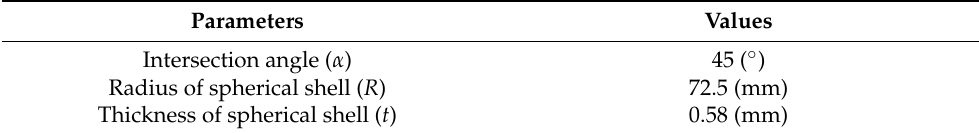
Table 2. Nominal dimensions of bulged